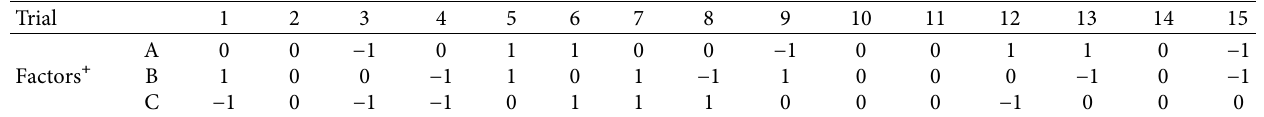
+ Tree most infuential factors that afect PVC weight loss were taken from the Pareto diagram. A, B, and C represent the three most infuential culture conditions depending on the tested strain.1, 0, and − 1 represent the levels of each culture condition, being ( − 1) the lowest level, (0) the middle level, and (1) the highest level.